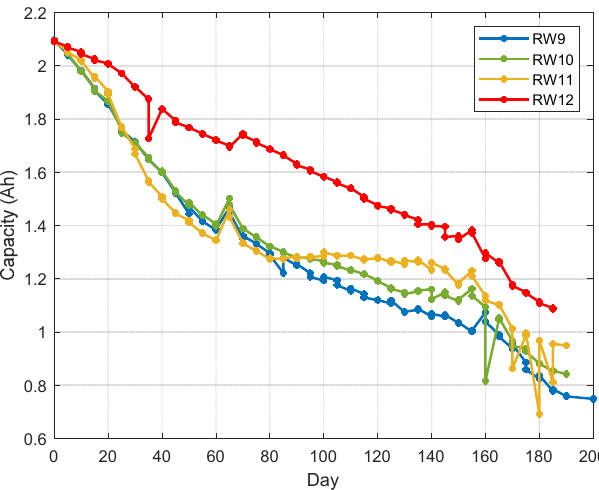
Figure 4. Capacities of the measured cells for four batteries, RW9, RW10, RW11, and RW12.